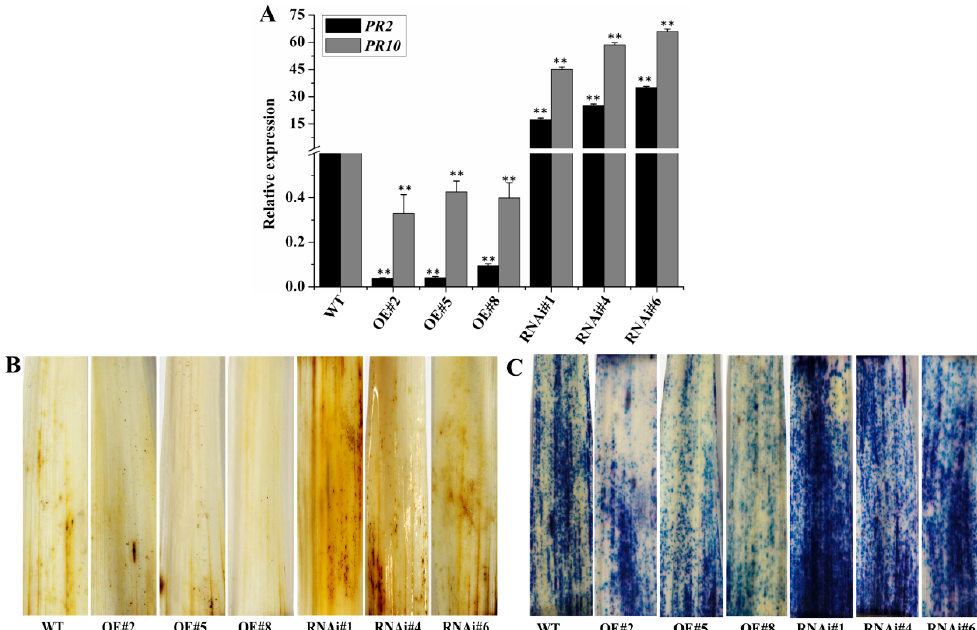
Figure 5. Defense-related traits identified in BEC1019 -overexpressing and -silenced plants. ( A ) The results of qRT-PCR analyses showing the transcript levels of wheat defense marker genes TaPR2 and TaPR10 in BEC1019 -overexpressing and RNAi plants. Double asterisks indicate significant differences relative to the control plants ( p ≤ 0.01, according to t tests). ( B ) The leaves of wild-type wheat and BEC1019 -overexpressing and RNAi plants were challenged with Blumeria graminis f. sp. tritici ( Bgt ) and sampled at 3 days post-infection (dpi) with DAB staining. ( C ) The leaves of wild-type wheat and BEC1019 transgenic plants were challenged with Bgt , sampled at 1 dpi, and used to observe cell death, which was detected by staining with trypan blue.